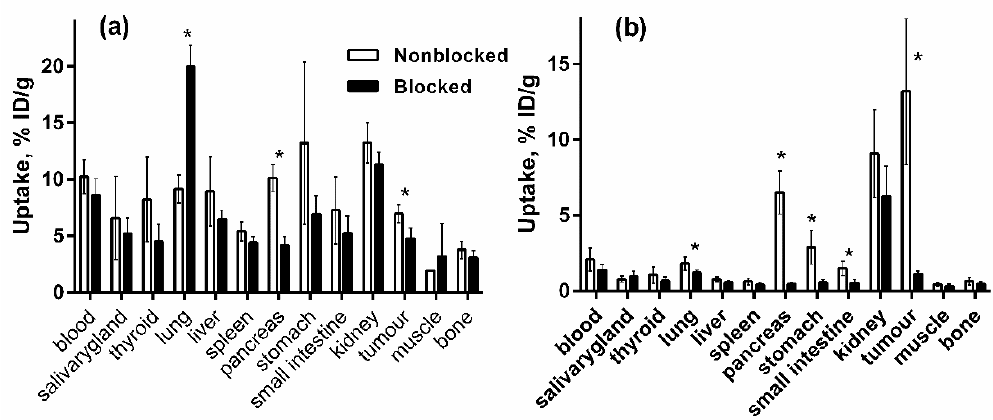
Figure 7. In vivo specificity of (a) [ 125 I]I-Tyr-PEG 2 -RM26 and (b) [ 111 In]In-DOTA-PEG 2 -RM26 in PC-3 tumour xenograft bearing BALB/C nu/nu at 30 min after injection. Blocking was performed by GRPR saturation with co-injection of non-labelled NOTA-PEG 4 -RM26. Asterisk (*) marks significant ( p < 0.05) difference. Data are presented as a mean ± SD; n = 4. Error bars might not be seen because they are smaller than the symbols.